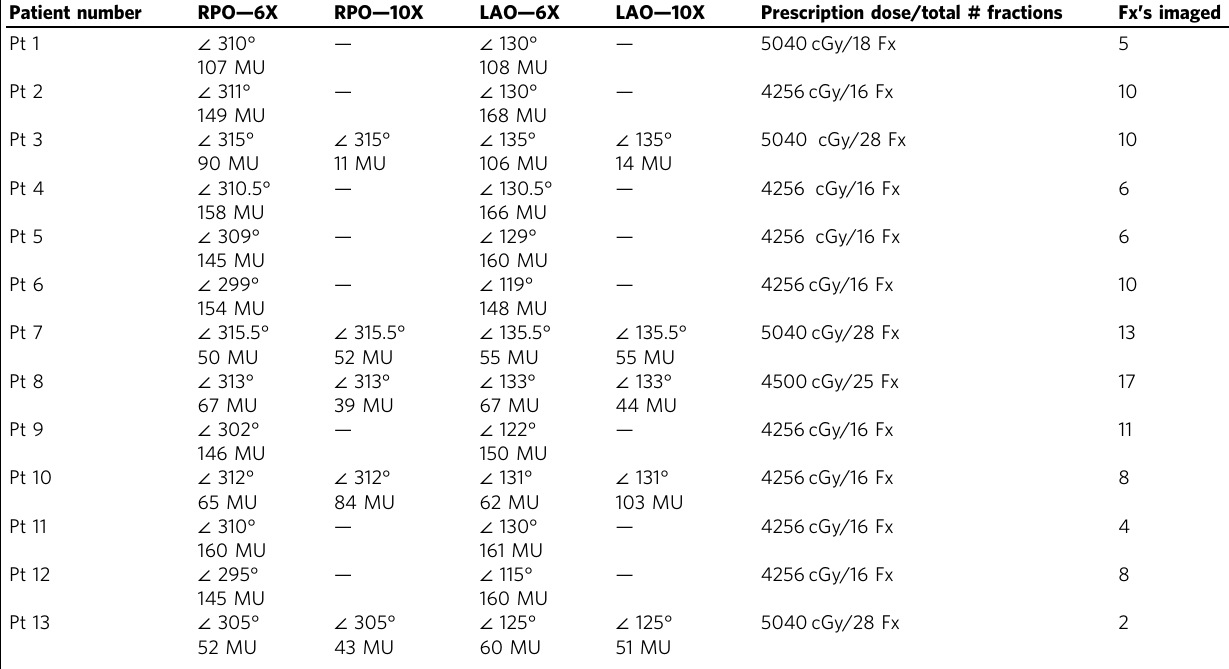
Treatment fi eldspeci fi cationsareorganizedbelowforeachpatient.Eachpatientreceived atleastonepairof RPOandLAO6Xbeams,additionallyPt ’ s3,7,8and10and13wouldreceivetwo, additional, opposing 10X beams. The total prescription dose is provided in the right column, followed by the number of fractions the total dose was distributed over. In the fi nal column, the number of fractions imaged is